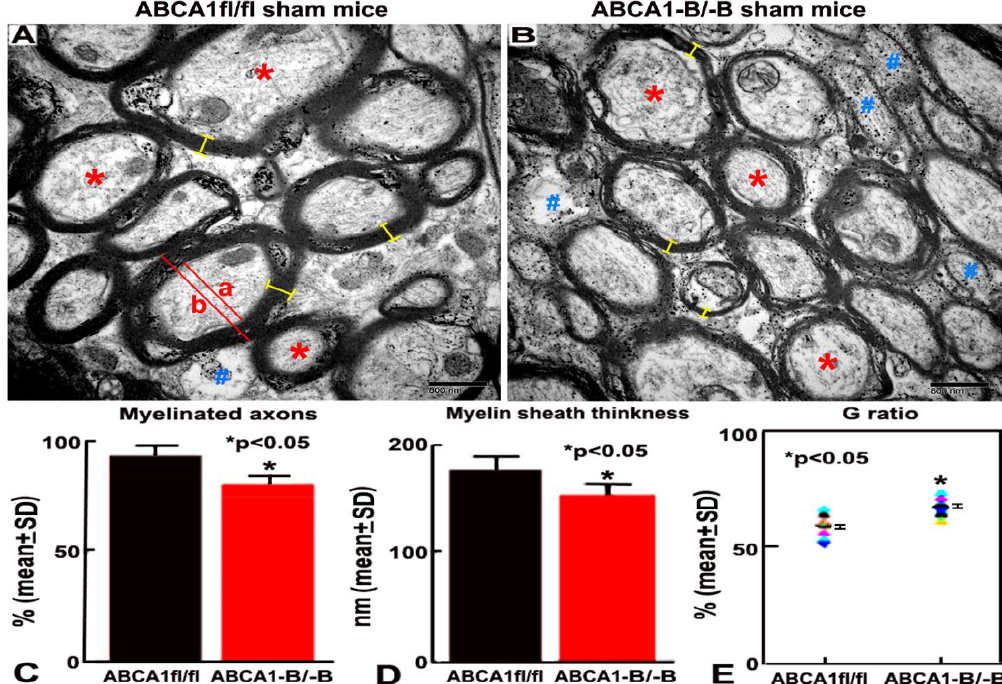
Figure 1. ATP-binding cassette transporter A1-deficient (ABCA1 -B/-B ) reduces myelination in the white matter (WM) of sham brain. ( A, B ) Electron microscopy (EM) images indicating the ultrastructure of WM in the corpus callosum (CC) from ABCA1-floxed ( ABCA1 fl/fl ) (A) and ABCA1 -B/-B (B) sham brain. ( C – E ) Quantitative data of percentage of myelinated axons, myelin sheath thickness, and G ratio. Stars ( * ) represent of myelinated axon characteristically on the outside of the myelin sheath of axons; Pond ( # ) represents hypomyelinated with reduplicated basal lamina or non-myelinated axon with thin myelin or complete lack of myelin around axons; Yellow bar ( - ) represents myelin thickness. G ratio = % of axon diameter (a) / diameter of axon with myelin sheath (b). Scale bar = 800 nm. * p < 0.05, n = 6/group. Int. J. Mol. Sci. 2019 , 20 , x FOR PEER REVIEW